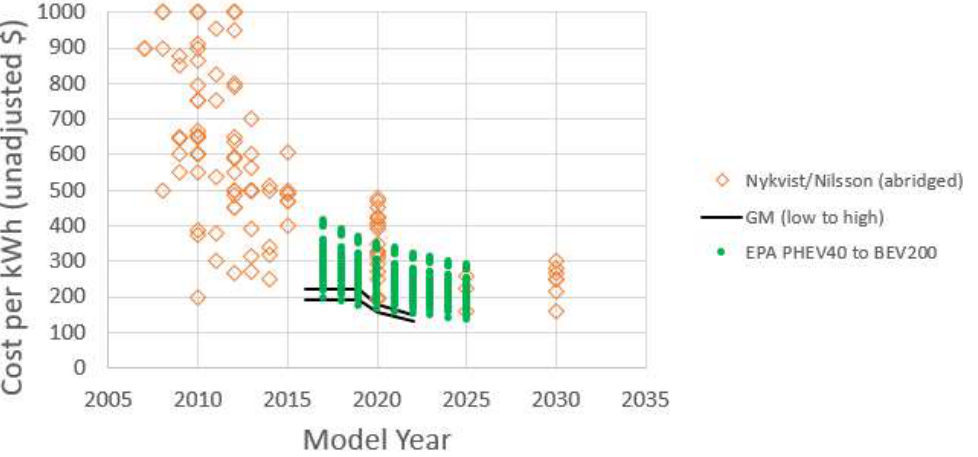
Figure 6. Comparison of Estimated Costs to Nykvist & Nilsson trends [22].